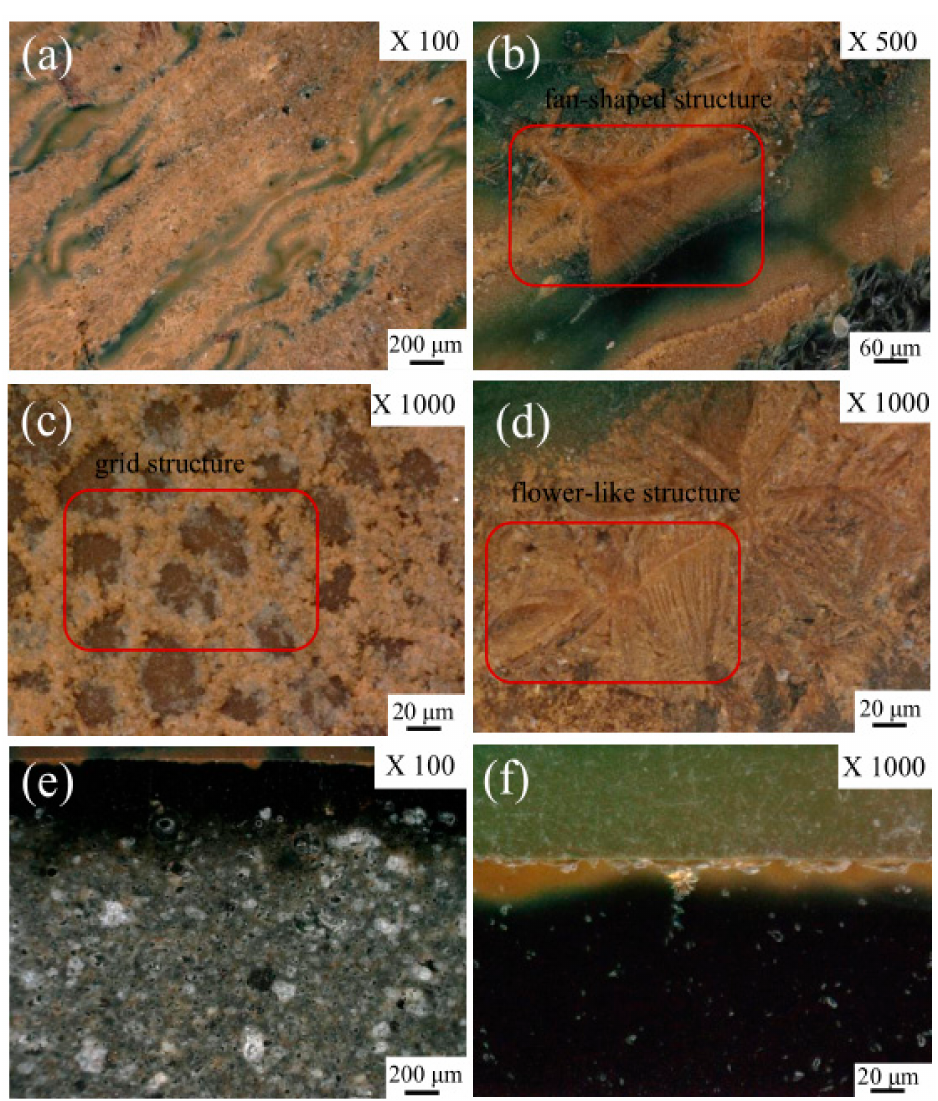
Figure 3. Optical observation of the HF sample with different magnifications: ( a – d ) the glaze surface; ( e , f ) the polished